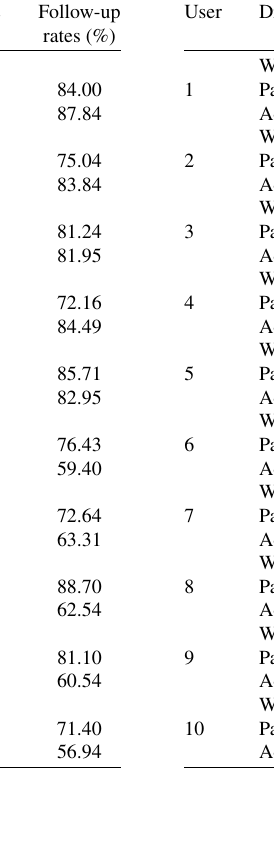
Table 3 Time averages, collisions and follow-up rates for the third zone User Driving mode Times (s) Collisions Follow-up rates